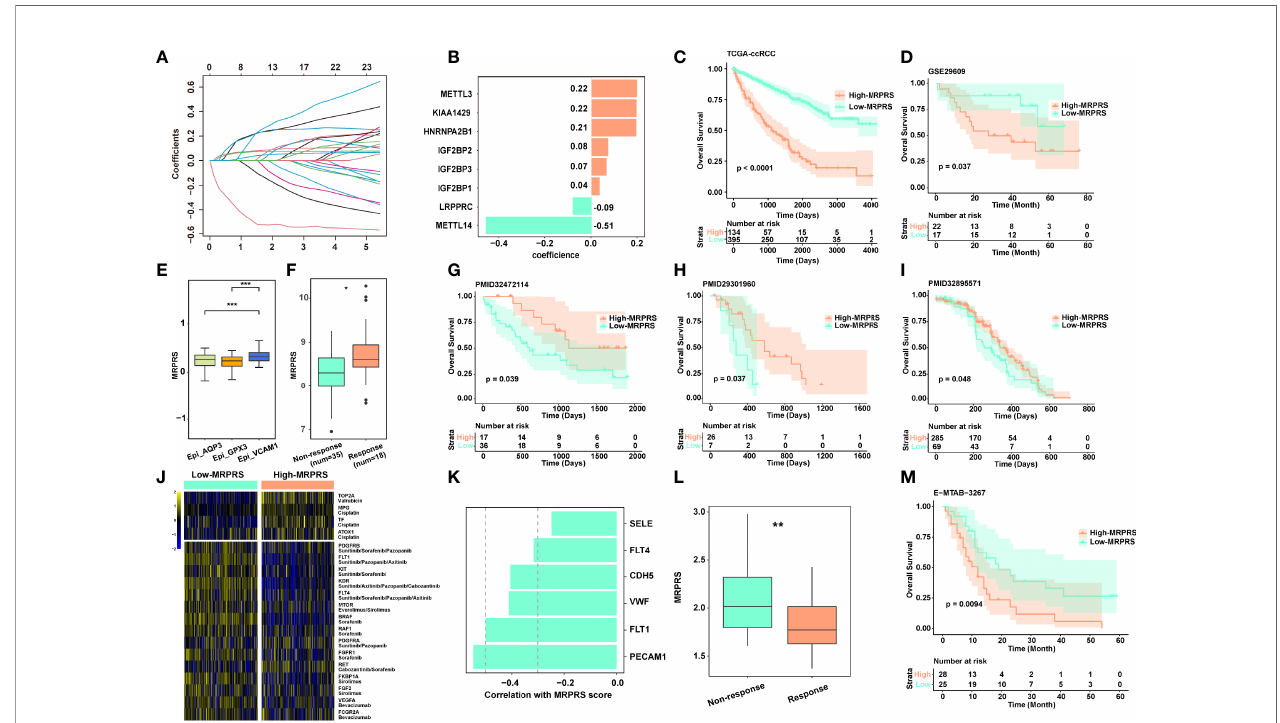
FIGURE 2 | (A) LASSO coef fi cient pro fi les of the 23 m 6 A RNA methylation regulators in the TCGA-ccRCC cohort. (B) The prognostic analyses for 23 m 6 A RNA methylation regulators in the TCGA-ccRCC cohort using the univariate Cox regression model. (C) Kaplan – Meier analysis of patients between high- and low-MRPRS groups in the TCGA-ccRCC cohort. (D) Validation cohort of MRPRS from GSE29609. (E) Box plot of different MRPRSs in 3 epithelial cell subsets. (F) The MRPRS between response and non-response groups in PMID32472114. (G – I) Kaplan – Meier analysis of three validation cohorts of immunotherapy in ccRCC (PMID32472114, PMID29301960, and PMID32895571). (J) Heatmap of chemotherapy and targeted drug-related genes between high- and low-MRPRS groups. (K) The correlation of MRPRS and genes associated with angiogenesis. (L) The MRPRS between response and non-response groups in ccRCC with sunitinib